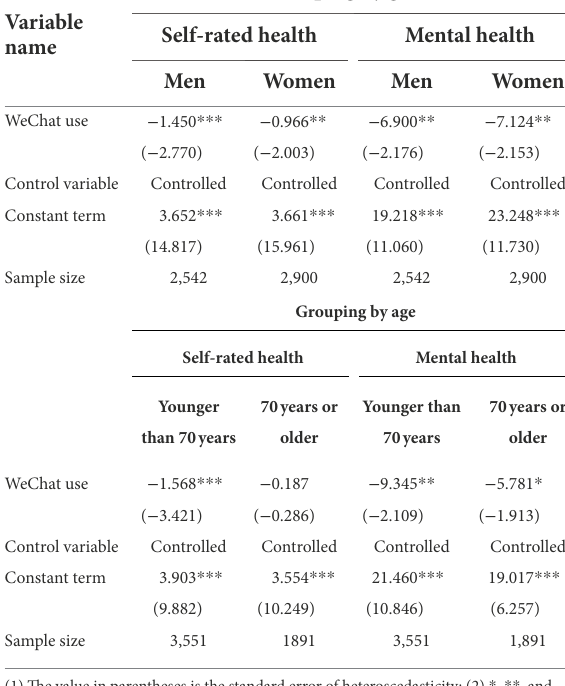
TABLE 5 Subsample test results (two-stage least squares; China Health and Retirement Longitudinal Study, China, 2018).